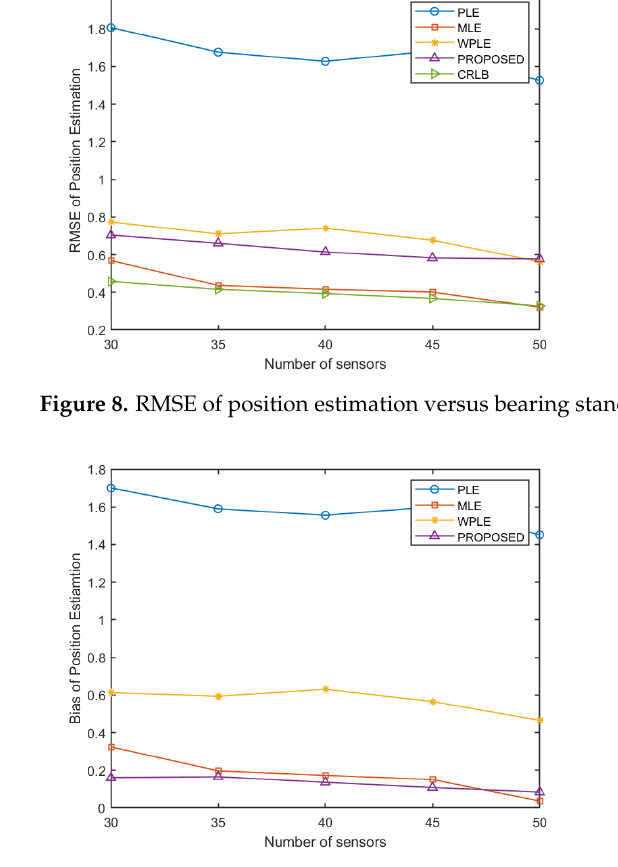
Figure 9. Bias of position estimation versus bearing standard deviation.